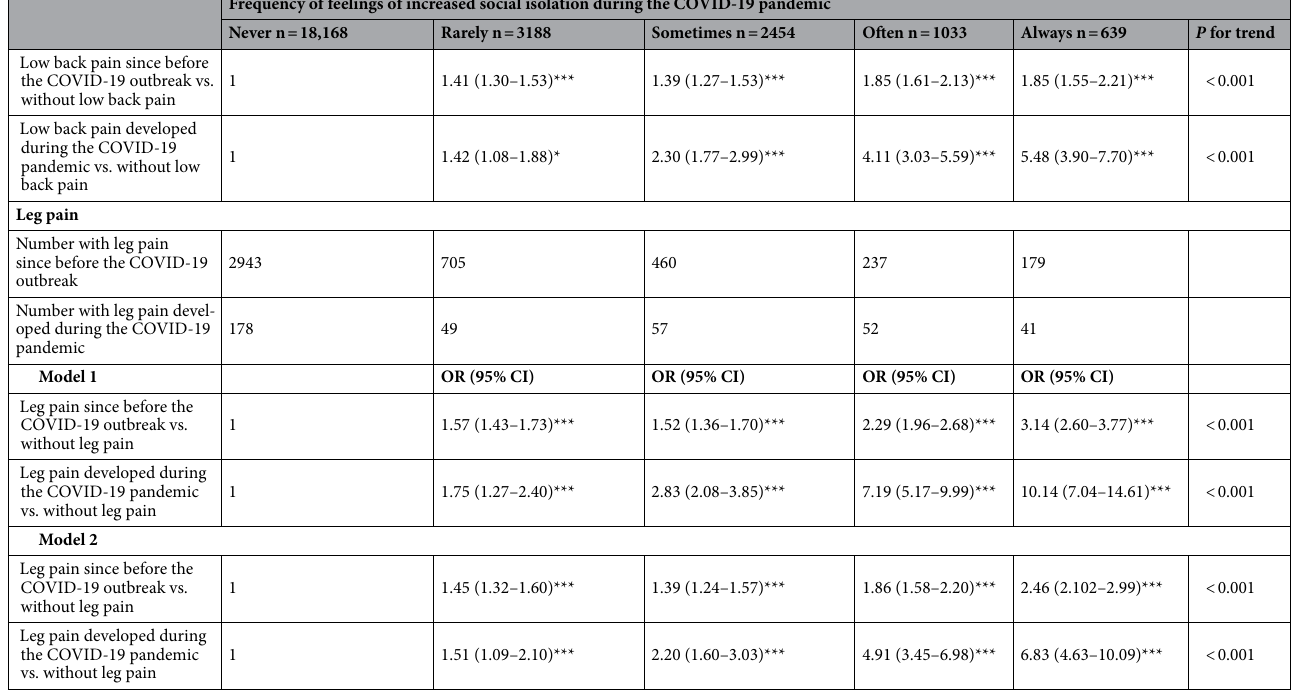
Table 2. The association of loneliness and a feeling of increased social isolation with the prevalence/incidence of pain during the COVID-19 pandemic. Model 1: Adjusted for age and sex. Model 2: Adjusted for age, sex, educational level, marital status, living alone, employment status, equivalized income, smoking status, alcohol consumption, physical activity, sleep duration, history of depression, and history of mental illnesses other than depression. COVID‑19 coronavirus disease 2019, OR odds ratio, CI confidence interval. Loneliness was measured using the Japanese version of the University of California, Los Angeles Loneliness Scale (Version 3), Short Form 3-item assessment tool. For loneliness, P values were calculated to compare participants without loneliness to those in the other categories by multinomial logistic regression. For social isolation, P values were calculated to compare participants who did not feel increased social isolation during the COVID-19 pandemic at all to those in the other categories by multinomial logistic regression. * p < 0.05, ** p < 0.01, *** p < 0.001. n =